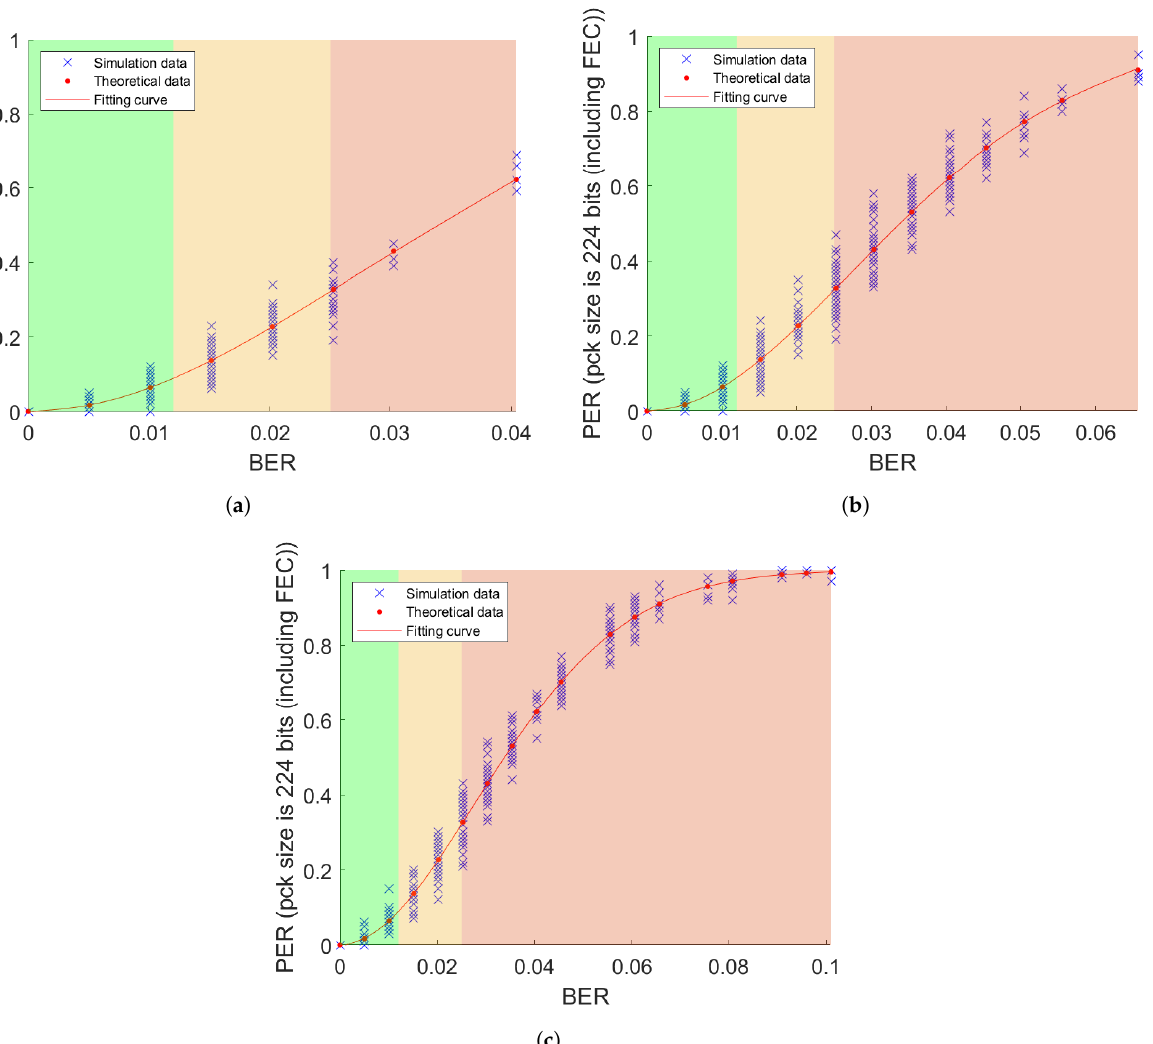
Figure 3. PER vs. BER values considering a packet with 16 bytes payload and Hamming (7,4) FEC for three different links: the “Good” link from node 4 to node 2 observed in topology 2 ( a ), the “Medium” link from node 2 to node 2 observed in topology 2 ( b ), and the “Bad” link from node 1 to node 3 observed in topology 1 ( c